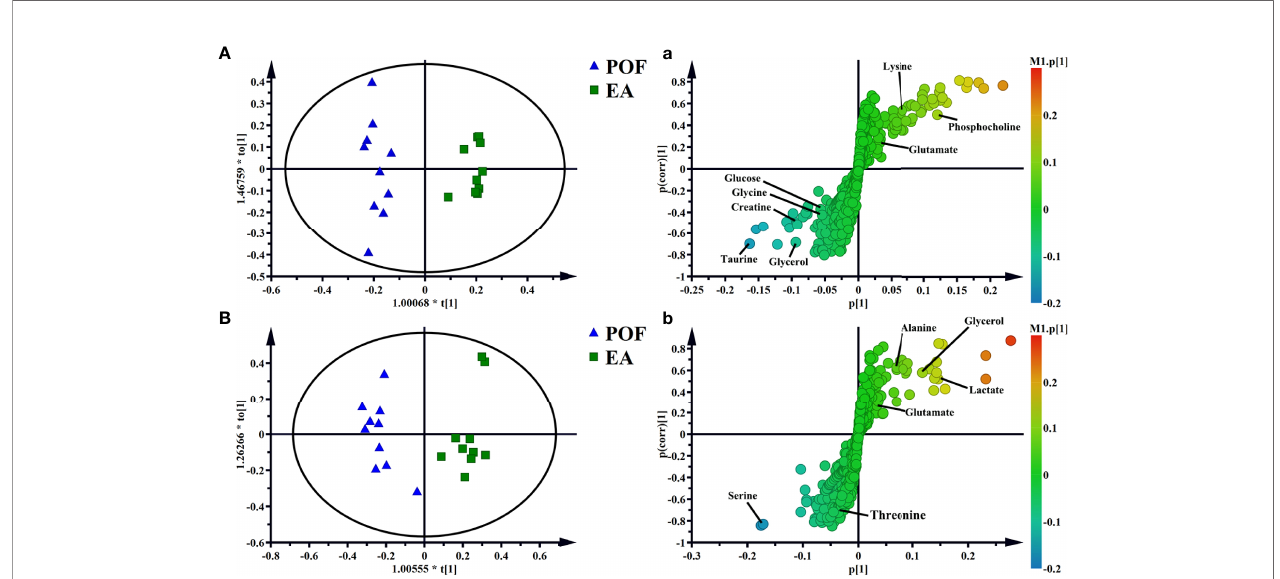
FIGURE 7 | OPLS-DA and S-plots of liver [ A and a , R2X(cum) = 0.606, R2Y(cum) = 0.966, Q2(cum) = 0.689] and kidney extracts in POF group and EA group B and b , R2X(cum) = 0.499, R2Y(cum) = 0.913, Q2(cum) = 0.65].